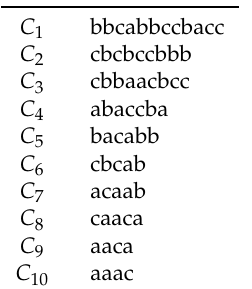
Table 3. The patterns used in Example